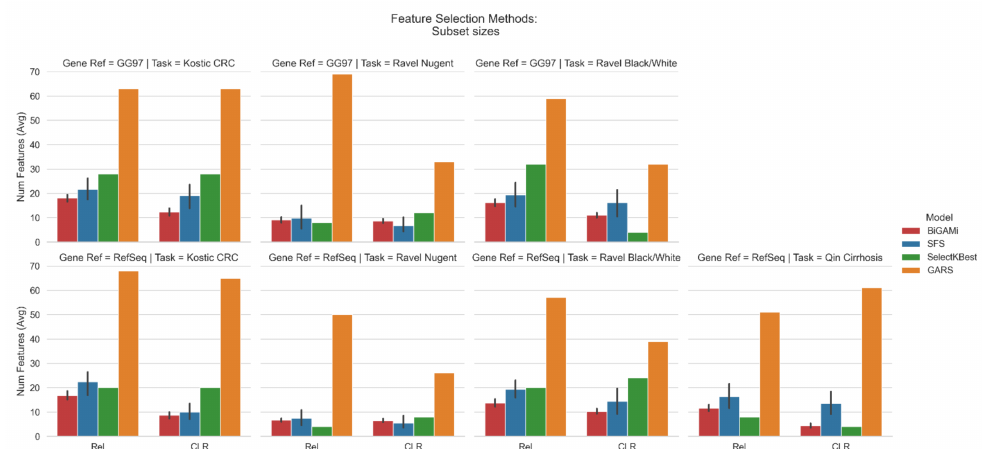
Figure 4. Average number of selected OTUs (including 99% confidence interval) for each data input achieved by the BiGAMi, SFS, and GARS methods. Confidence intervals were calculated by the Seaborn plotting library using the bootstrap resampling technique with a mean estimator. ( Top ): Selected OTUs for GG97-based data input. ( Bottom ): Selected OTUs for RefSeq-based data input.